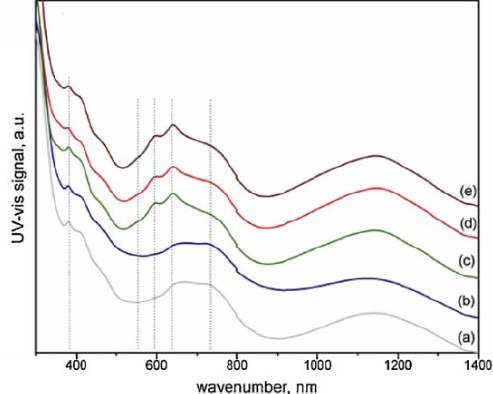
Figure 5. UV–vis spectroscopic patterns of ( a ) RhNicoimp, ( b ) Cat600600, ( c ) Cat600850, ( d ) Cat850600, and ( e ) Cat850850. Reprinted with permission from [151], copyright 2019, Elsevier.